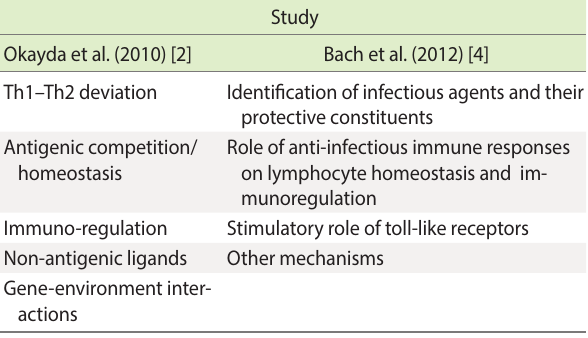
Table 1. Mechanisms of the hygiene